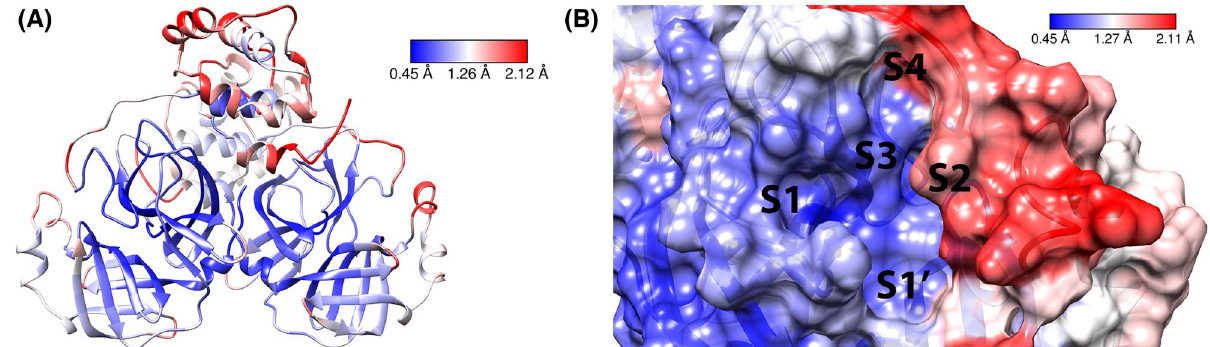
Figure 3. ( A ) RMSF values of MD simulation for 6LU7 complex applied on SARS-CoV-2 M pro dimer ribbons representation. ( B ) RMSF values of MD simulation for 6LU7 complex applied on SARS-CoV-2 M pro active site